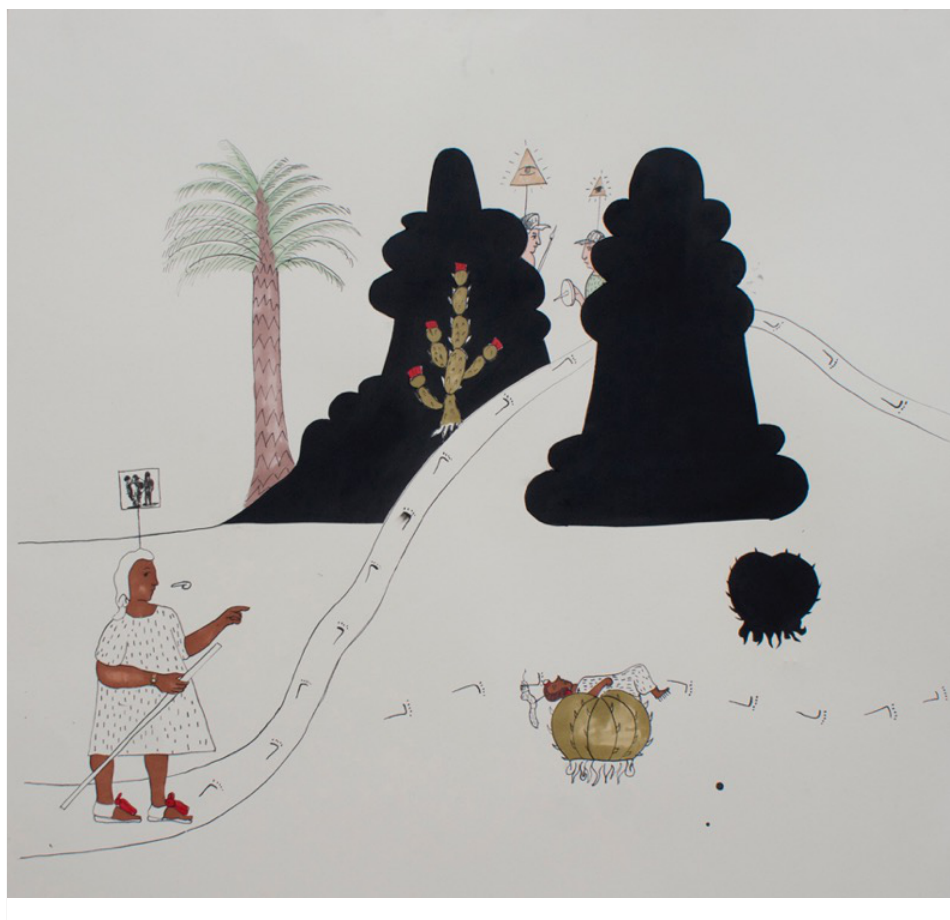
Gabriel Garcilazo, Dystopic Magical Codex: Codex 7 (The Road to Venezuela) , 2015. Charcoal and ink on paper. 66.5 x 66.5 cm. Private collection. Image courtesy of the